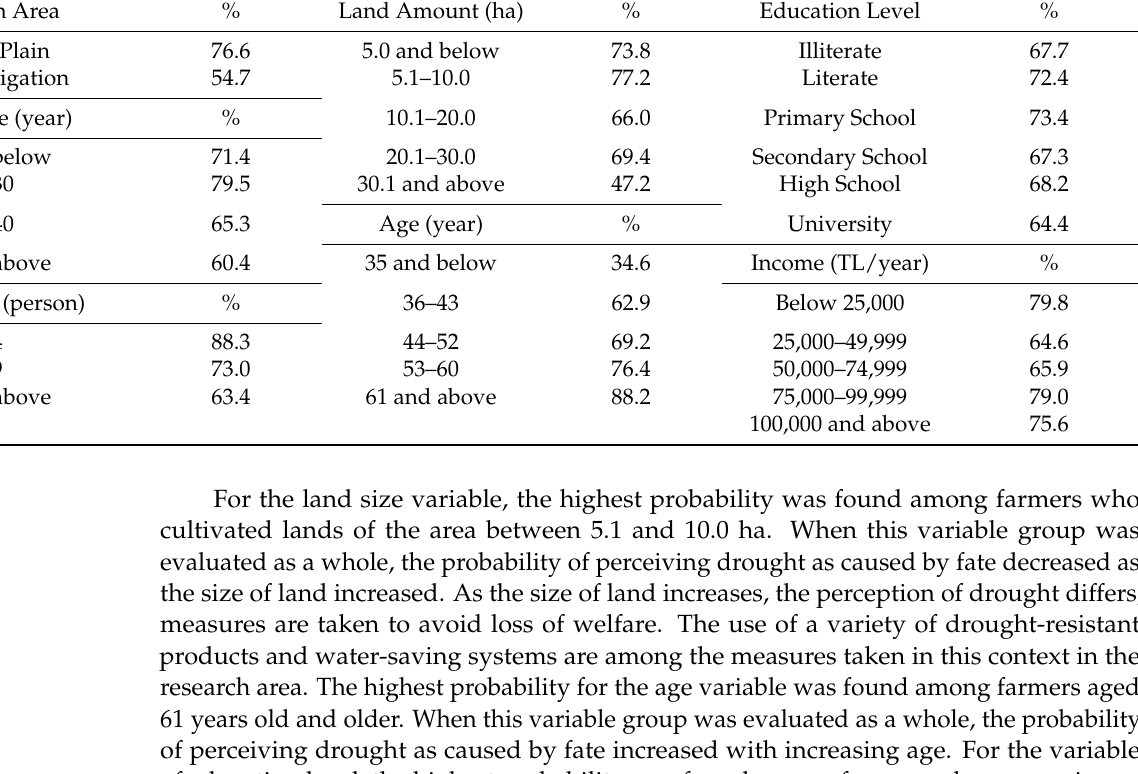
Table 3. Probability of perceiving drought as fate for each independent variable in the ordinal analysis. Variable Probability Variable Probability Variable Probability Irrigation Area % Land Amount